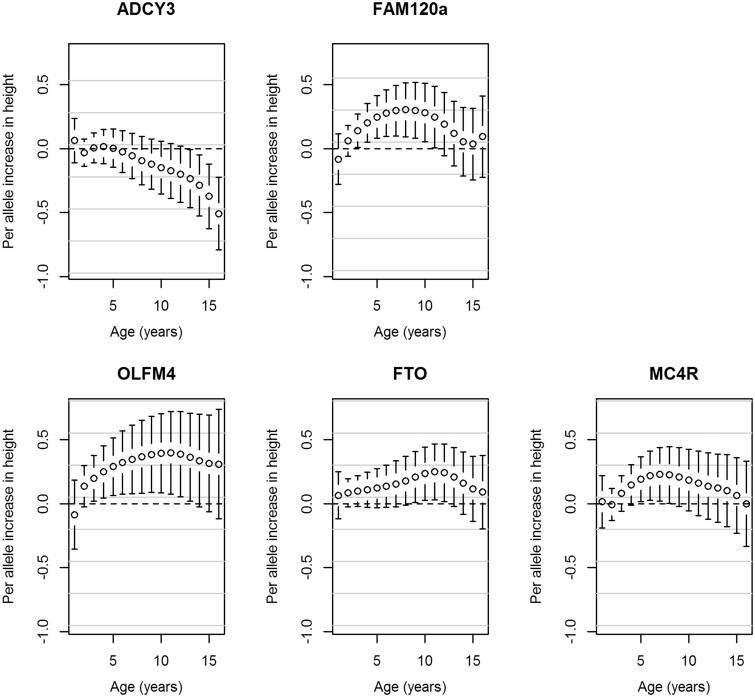
Associations from the ALSPAC cohort between the genome-wide significant SNPs and height from age one to 16 years. Error bars represent the regression coefficient of height and 95% confidence intervals derived from the longitudinal additive genetic models. The SNPs are aligned to the minor allele.